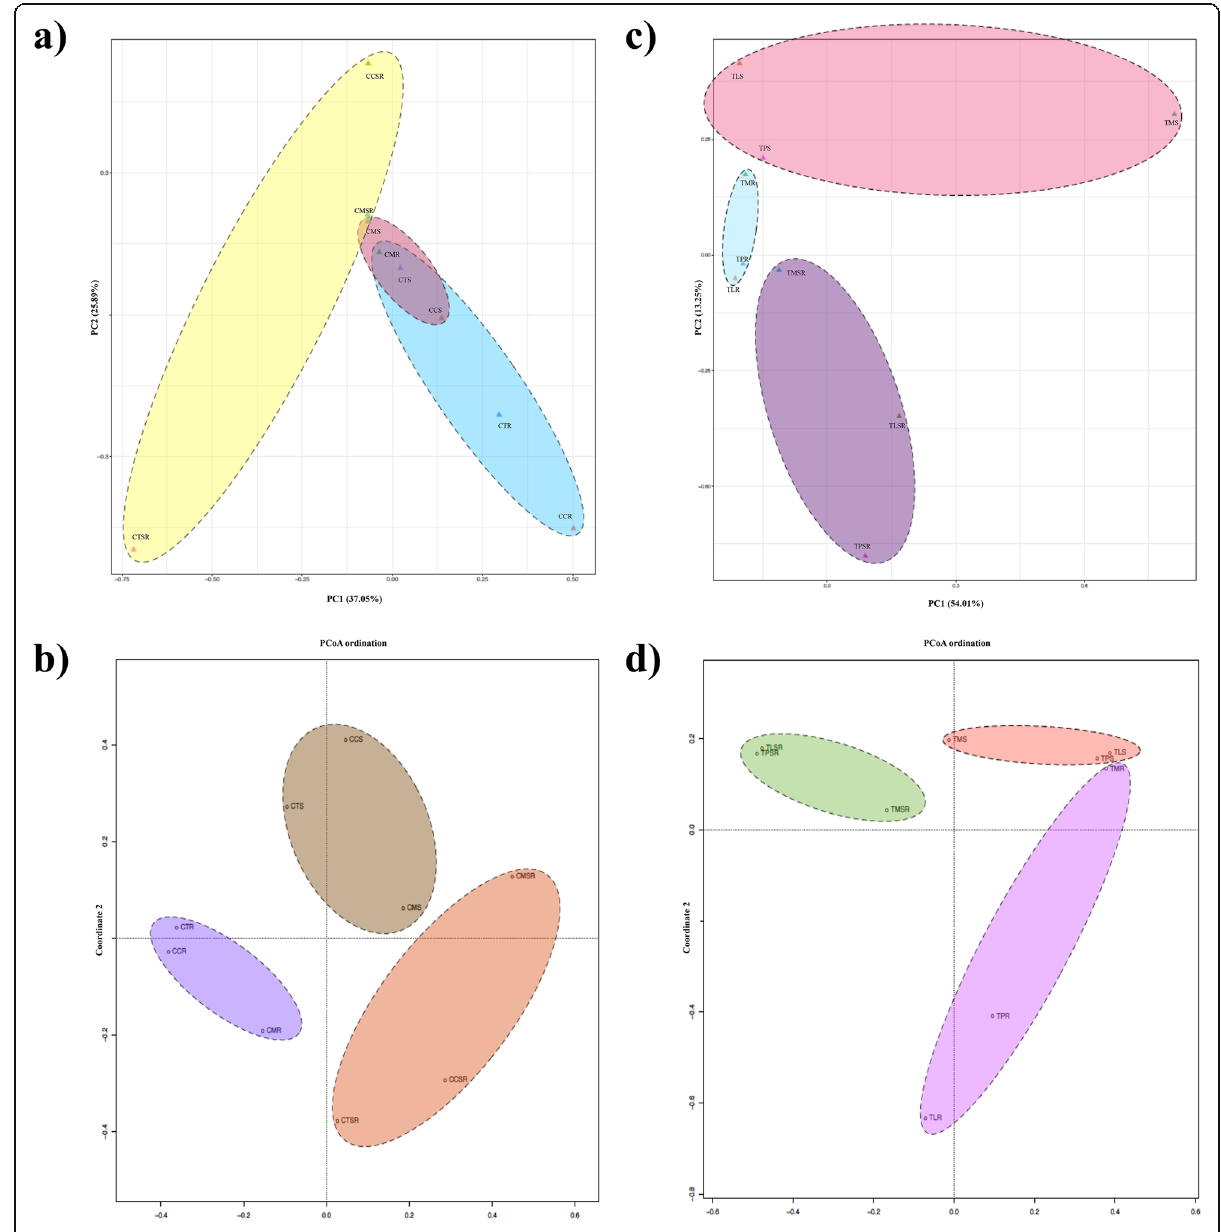
Fig. 4 Principal component (PCA) and principal coordinate (PCoA) analyses of the UniFrac distances of bacterial communities in the different samples of C. annuum , and S. lycopersicum . a PCA and b PCoA of the bacterial communities from C. annuum . c PCA and d PCoA of the bacterial communities from S.